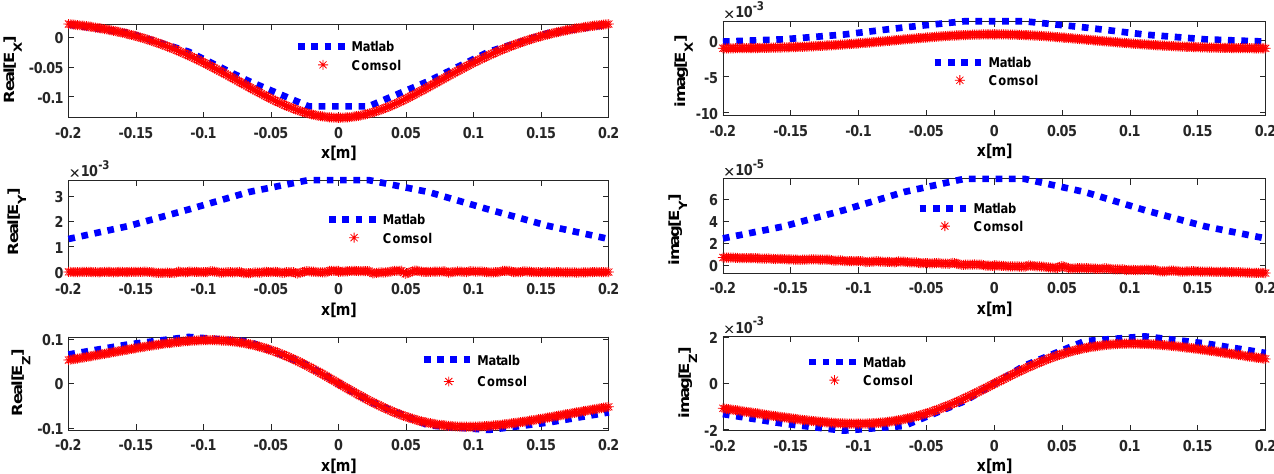
Figure 3. Real part ( left ) and imaginary part ( right ) of the scattered electric field by two PEC spheres. In particular, Matlab results (blue color dot lines) are perfectly superimposed on Comsol results (red marker color lines). Sphere I and sphere II are translated at 0.3 m and − 0.3 m along z -axis, and the selected frequency is f = 3